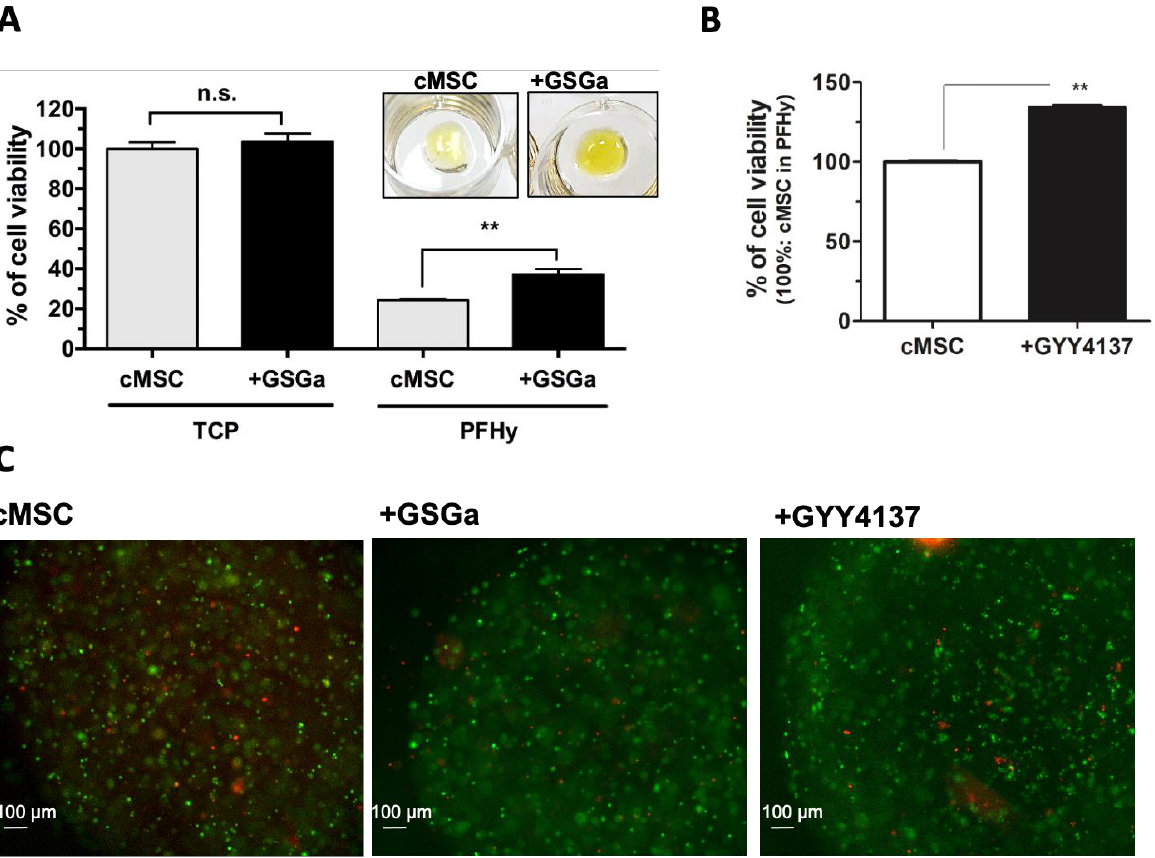
Figure 4. Preconditioning with H 2 S slow-releasing agents protects stem cell 3D culture from photo-polymerization damage. ( A ) WST-1 cell viability assay of cMSC (cMSC) and preconditioned cMSC for three days with 680 µ g/mL of GSGa (+GSGa) after PFHy polymerization; 100% was the control represented by cMSC grown on the tissue culture plate (cMSC/TCP); the digital images of the 3D-PHy cell cultures after metabolic WST-1 assay are at the top; ( B ) WST-1 cell viability assay of cMSC embedded in PFHy without (cMSC) and with preconditioning for three days with 100 µ M of GYY4137 (+GYY4137); error bar indicates S.D. and ** p value ≤ 0.01; ( C ) Representative fluorescence micrographs of LIVE/DEAD assay of cMSC and preconditioned cMSC with GSGa (+GSGa) or with GYY4137 (100 µ M) (+GYY4137) that were embedded in PFHy. Scale bars are 100 µ m. Experiments were performed as three or four biological replicates. n.s. = not significant.